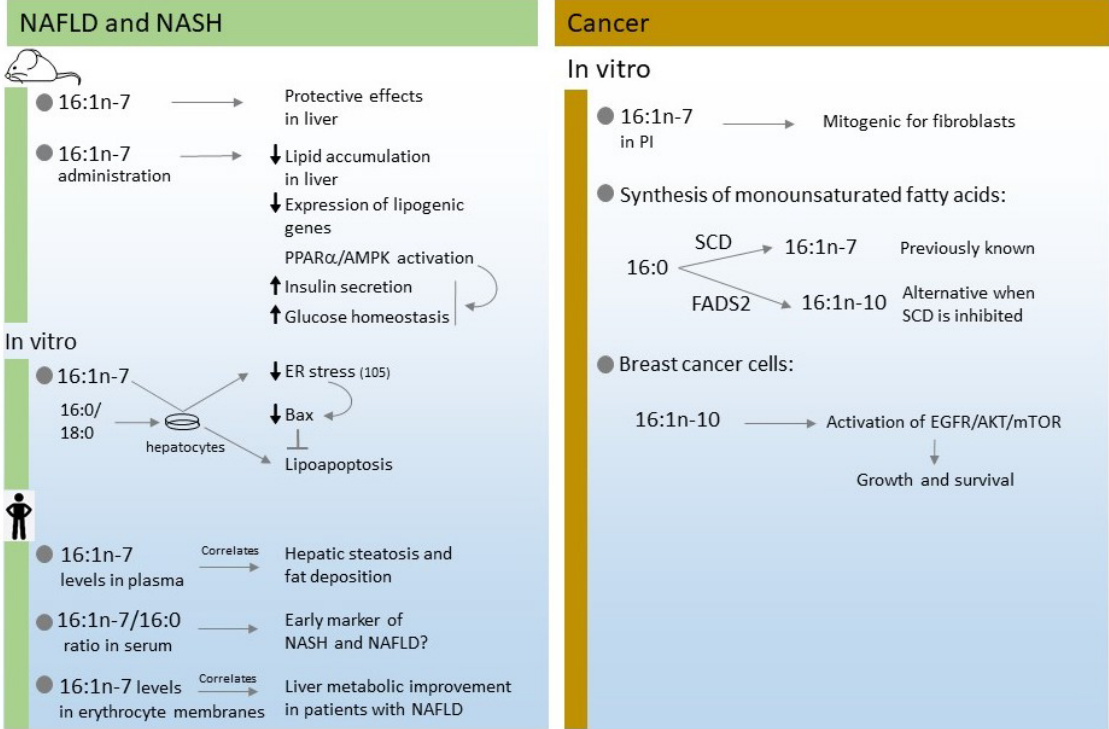
Figure 5. Summary of effects of hexadecenoic fatty acids in liver diseases ( left ) and cancer ( right ).